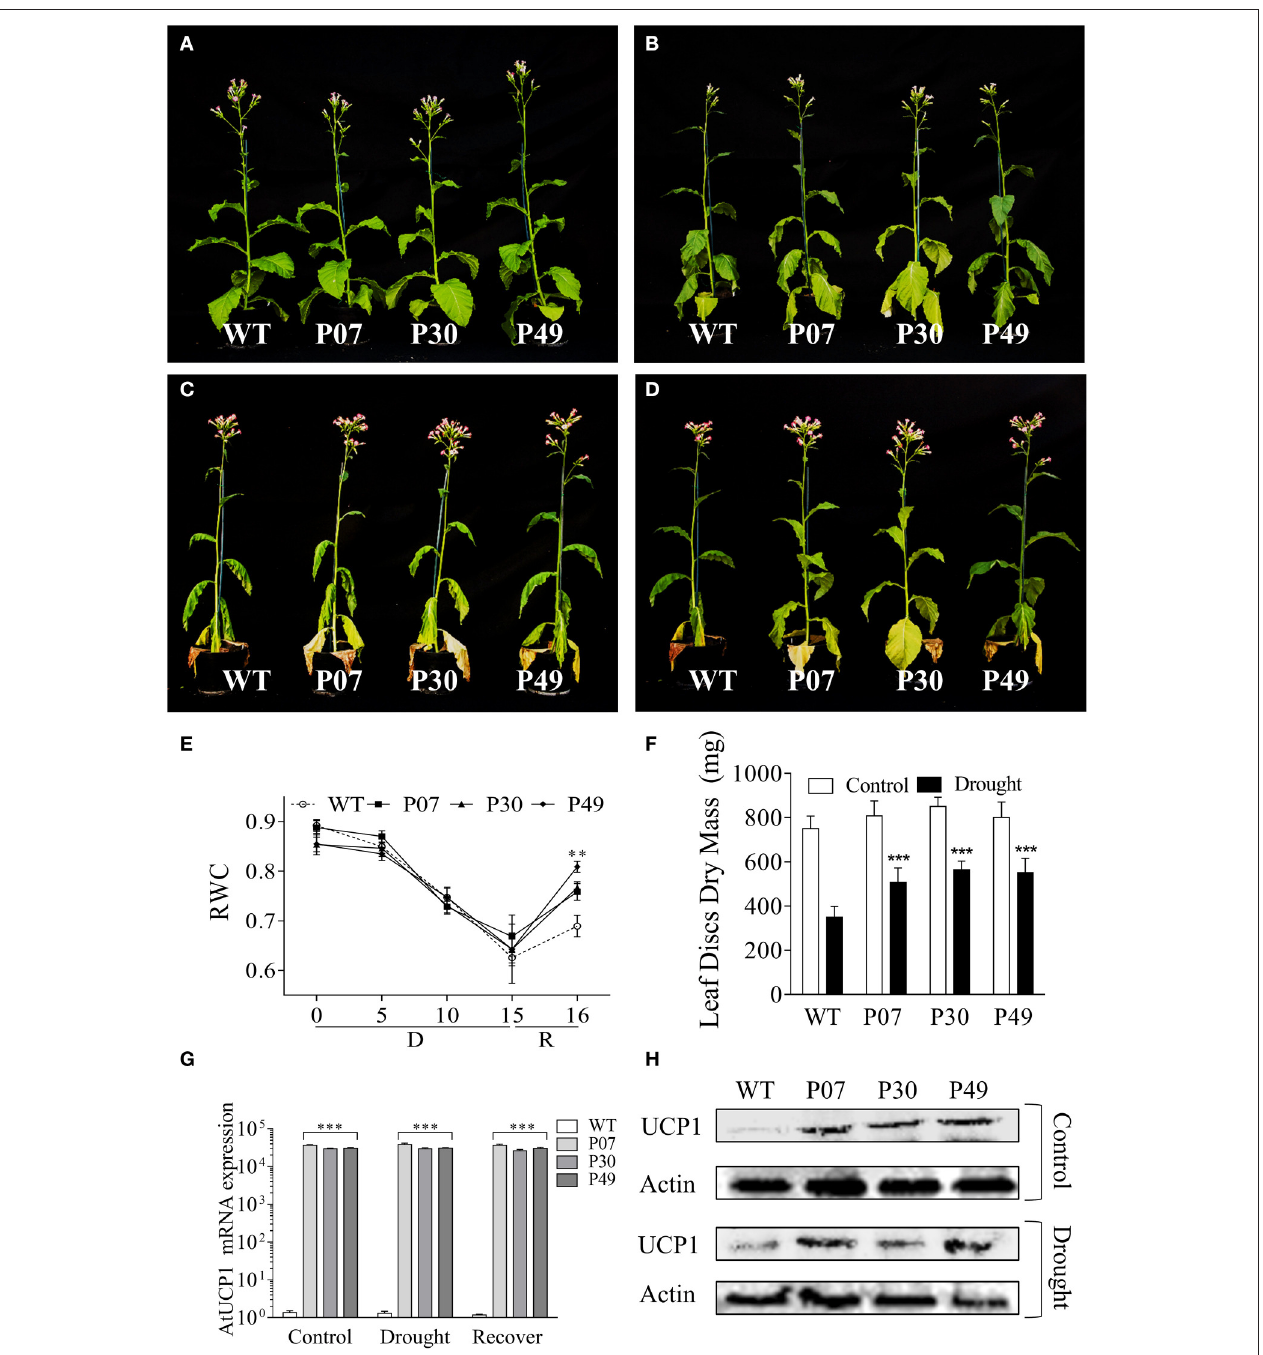
FIGURE 1 | UCP1-oe lines recover faster from drought stress than do WT upon rewatering. Plants were grown until (A) the reproductive phase of development, after which irrigation was stopped. Plants started to show symptoms of drought stress after (B) 9 days without irrigation, and they were maintained without irrigation for (C) 15 days after the start of the drought treatment. (D) Transgenic plants recovered faster after 1 day of recovery. (E) Relative water content (RWC) was monitored on the first expanded leaf during the whole course of the experiment. (F) The absolute dry mass of the first fully expanded leaf (20 leaf discs) was compared between control and drought-stressed plants. (G) The heterologous UCP1 was overexpressed in flower buds of all three transgenic lines (P07, P30, and P49) as previously described for the leaves. (H) Immunoblot analysis of the flower buds of WT and transgenic lines P07, P30, and P49 under control and drought conditions was performed using an anti-UCP1 antibody. The gel loading control was estimated using an anti- β -actin antibody. Bars and points represent the means ± SD. Bars with *** differ significantly from the WT ( P < 0.01). Points with ** mean that all transgenic lines differ from the WT ( P < 0.05). D, Drought; R, Recovery.